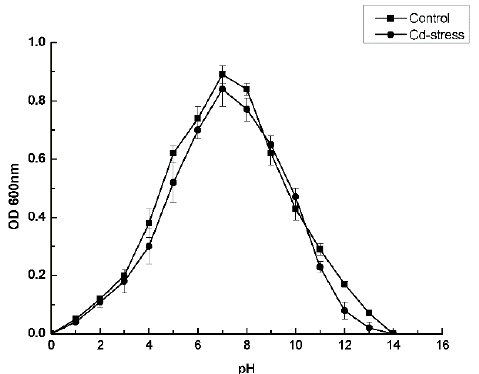
Figure 2. The optimum pH of P. shigelloides H5 with and without Cd 2+ stress. ( p = 0.007).